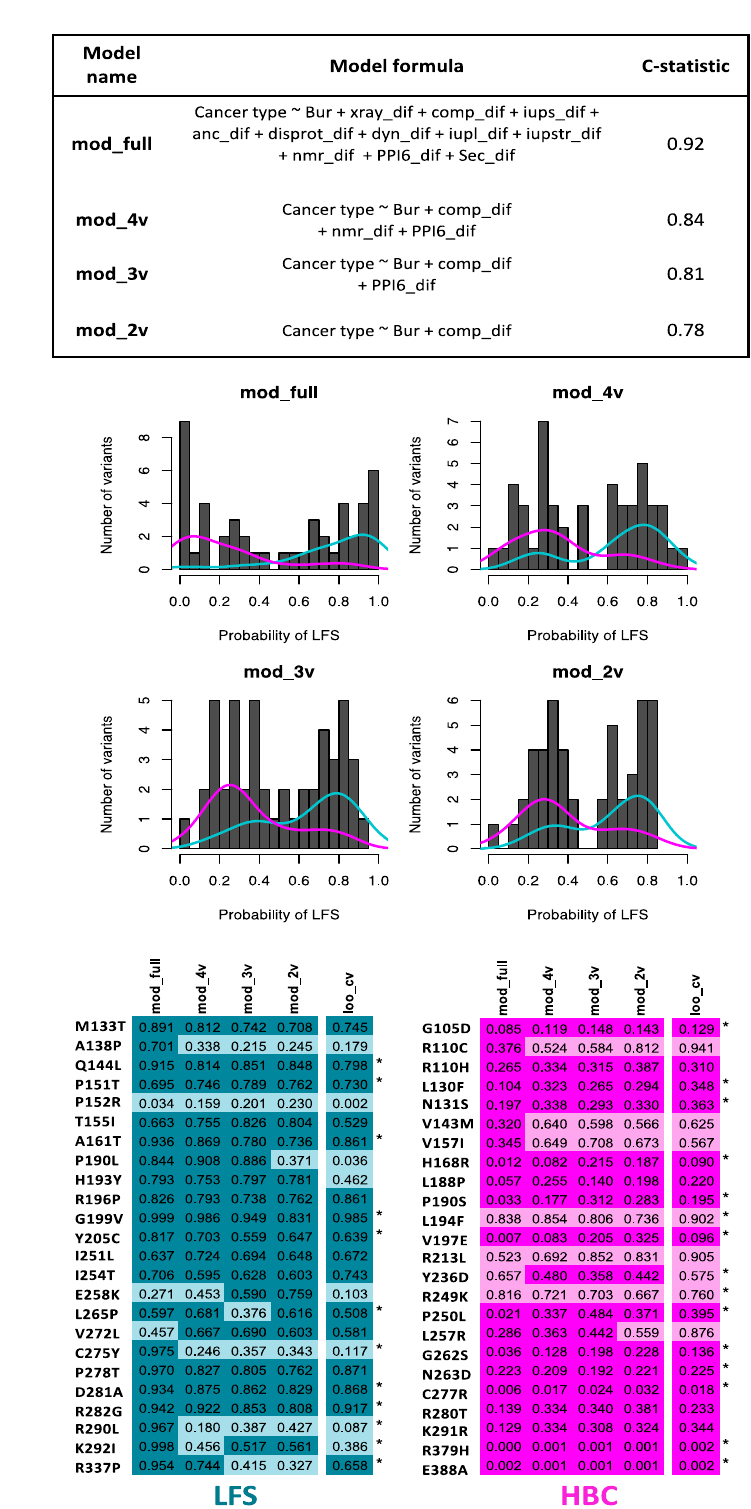
Figure 3. Protein conformation parameters are associated with disease phenotype and may have predictive value. ( a ) Multivariate logistic regression models for prediction of phenotype class (LFS or HBC) using a range of available protein conformation related explanatory variables describing different protein conformation aspects (full model, mod_full). A reduced model (mod_4v) was produced by stepwise variable exclusion from the full model (rms package). Further reduction was done by progressive manual removal of the least well performing variable to produce models